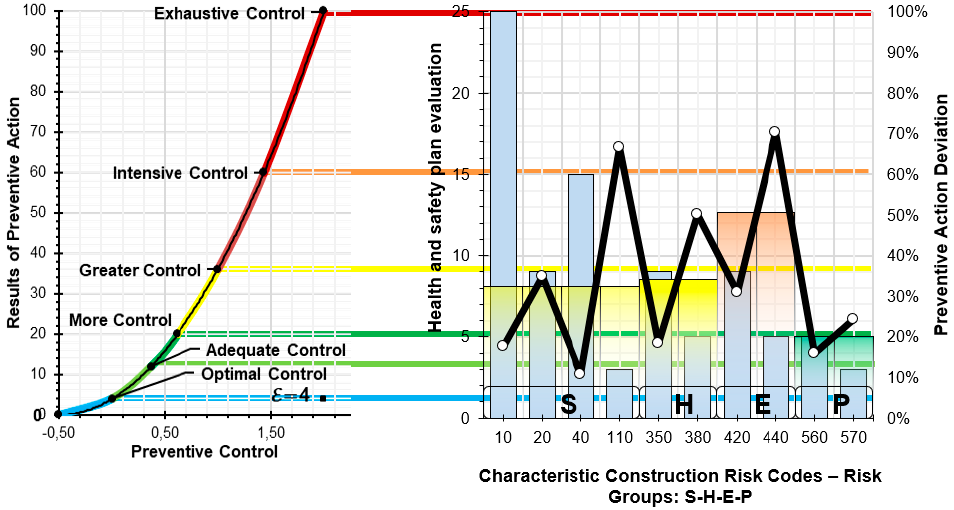
Figure 12. Results and comparative graphs.